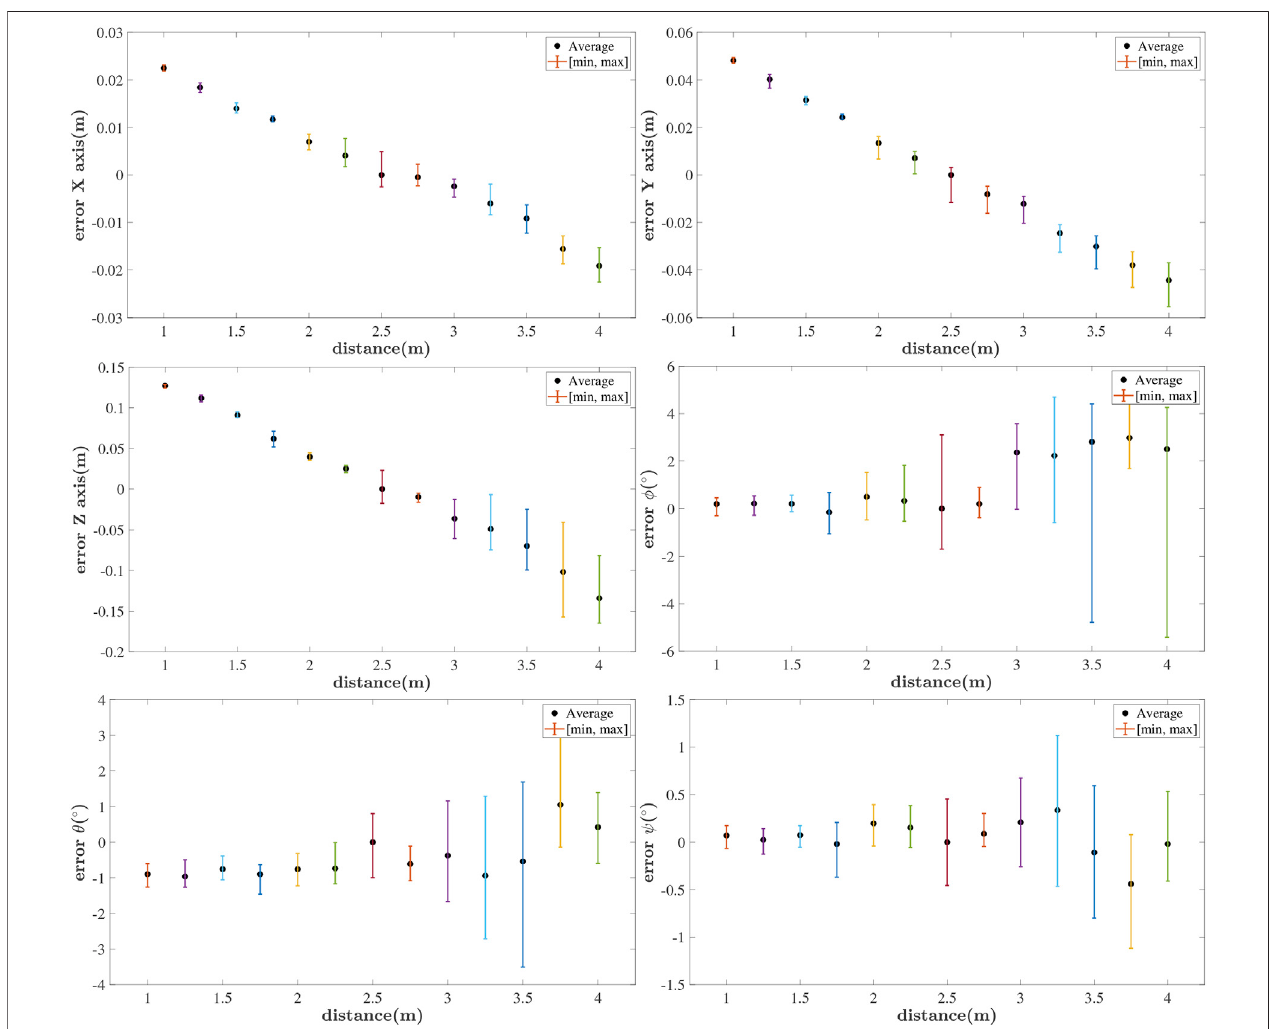
FIGURE 7 | Attainable pose measurement error for stationary UAVs at different distances | x l − x f | .